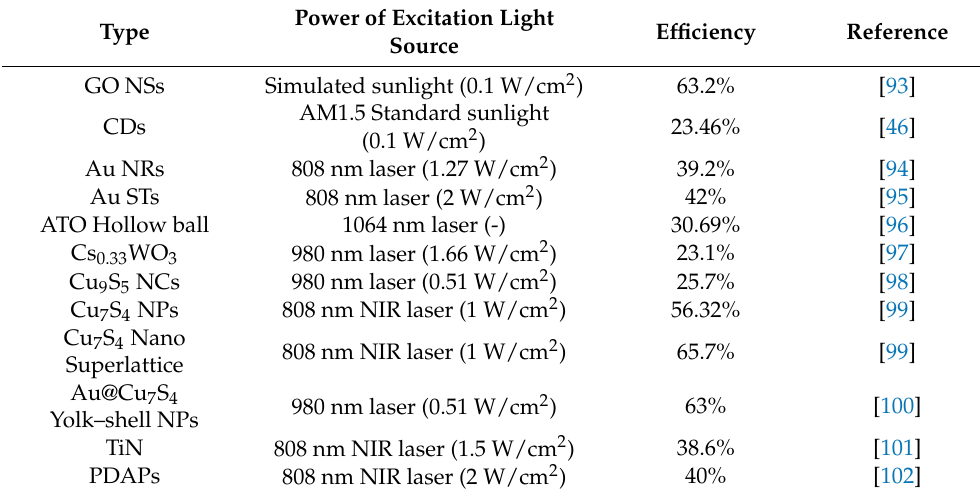
Table 1. Conversion efficiency of photothermal materials.